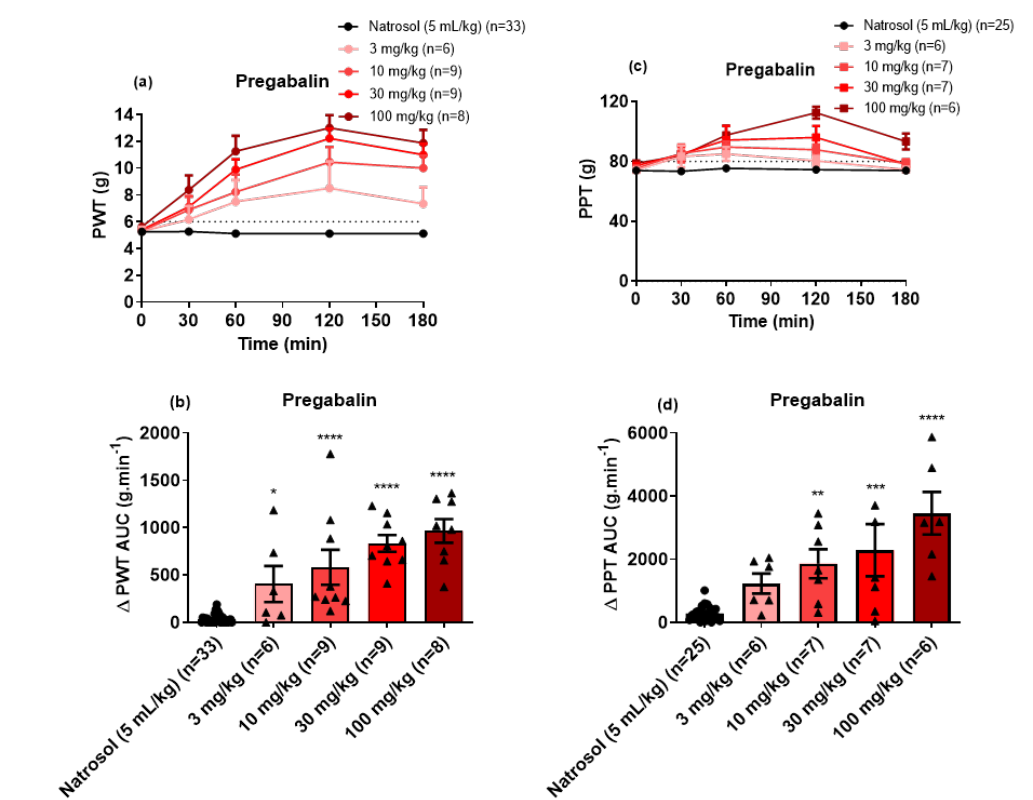
Figure 4. ( a ) Mean ( ± SEM) paw withdrawal threshold (PWT) versus time curves. ( b ) Scatter diagrams of the mean ( ± SEM) extent and duration of action quantified as the mean ( ± SEM) areas under the ∆ PWT versus time curves ( ∆ PWT AUC values) for the combined left and right hindpaws of individual CIPN-rats following the administration of single oral bolus doses of pregabalin at 3 mg/kg (n = 6), 10 mg/kg (n = 9), 30 mg/kg (n = 9) and 100 mg/kg (n = 8) relative to vehicle (n = 33). The horizontal dotted line in Panel ( a ) indicates fully developed mechanical allodynia (PWT ≤ 6 g) in the bilateral hindpaws. ( c ) Mean ( ± SEM) paw pressure threshold (PPT) versus time curves. ( d ) Scatter diagrams of the mean ( ± SEM) extent and duration of action quantified as the mean ( ± SEM) areas under the ∆ PPT versus time curves ( ∆ PPT AUC values) for the combined left and right hindpaws of individual CIPN-rats following the administration of single oral bolus doses of pregabalin at 3 mg/kg (n = 6), 10 mg/kg (n = 7), 30 mg/kg (n = 7) and 100 mg/kg (n = 6) relative to vehicle (n = 25). The horizontal dotted line in Panel ( c ) indicates fully developed mechanical hyperalgesia (PPT ≤ 80 g) in the bilateral hindpaws. * p ≤ 0.05 , ** p < 0.01 ***, p < 0.001 and **** p < 0.0001.